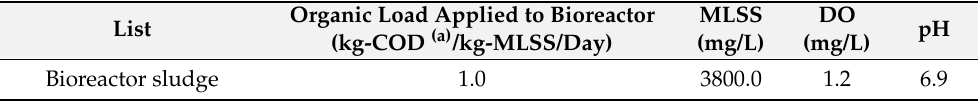
Table 2. Characteristic of bioreactor condition and bioreactor